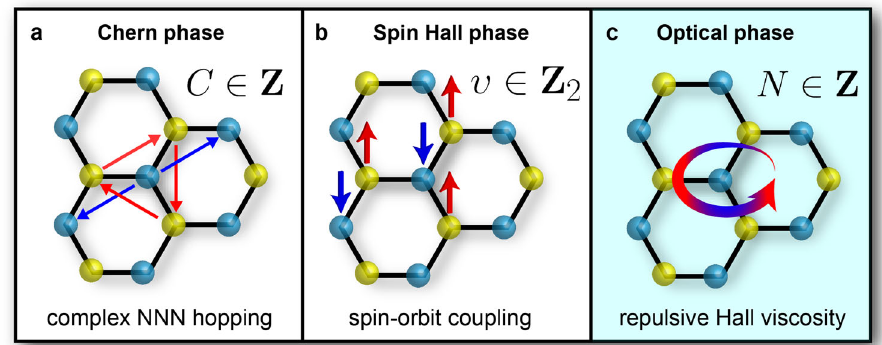
Fig. 1 Topological phases of graphene. a The Chern phase C 2 Z arises from complex next-nearest-neighbor (NNN) hopping and is related to charge transport. b The quantum spin Hall phase υ 2 Z , also known as the 2D topological insulator, is due to spin – orbit coupling and leads to nontrivial spin 2 transport. c The optical phase N 2 Z we put forth in this paper is a consequence of repulsive Hall viscosity and connected to polarization transport. These three phases can be identi fi ed as the Chern insulator, quantum spin Hall insulator and viscous Hall insulator,